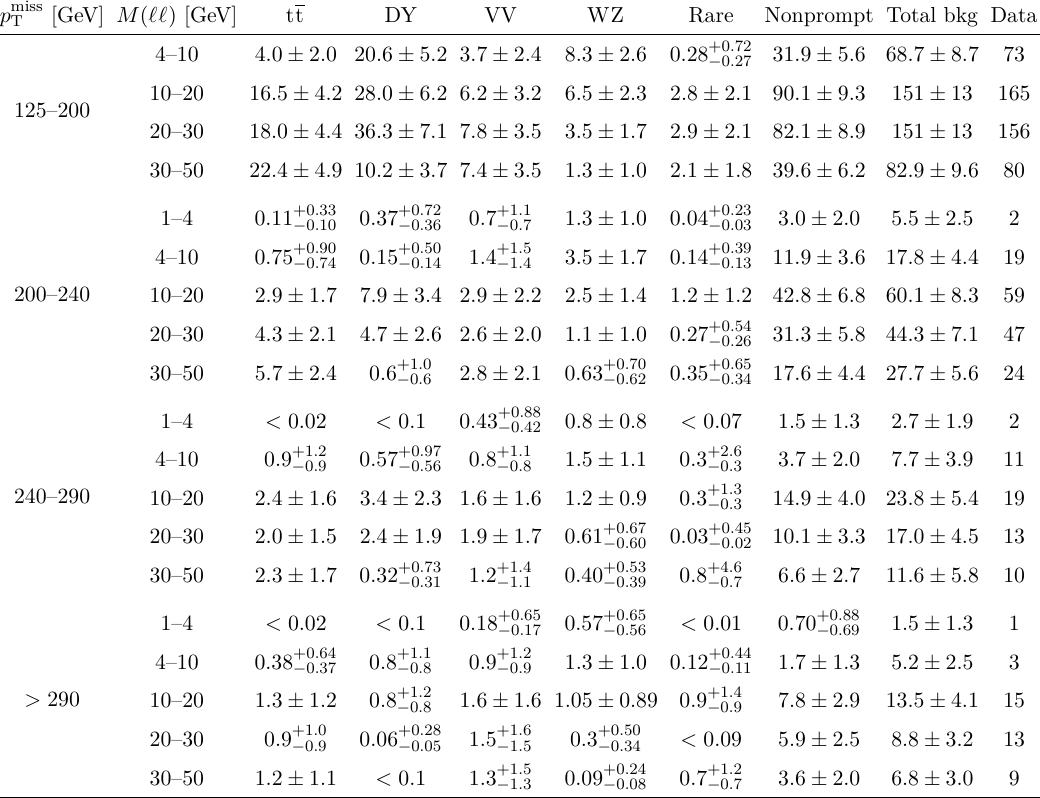
Table 4 . Observed and predicted yields as extracted from the maximum likelihood fit, in the 2 ‘ -Ewk SRs. Uncertainties include both the statistical and systematic